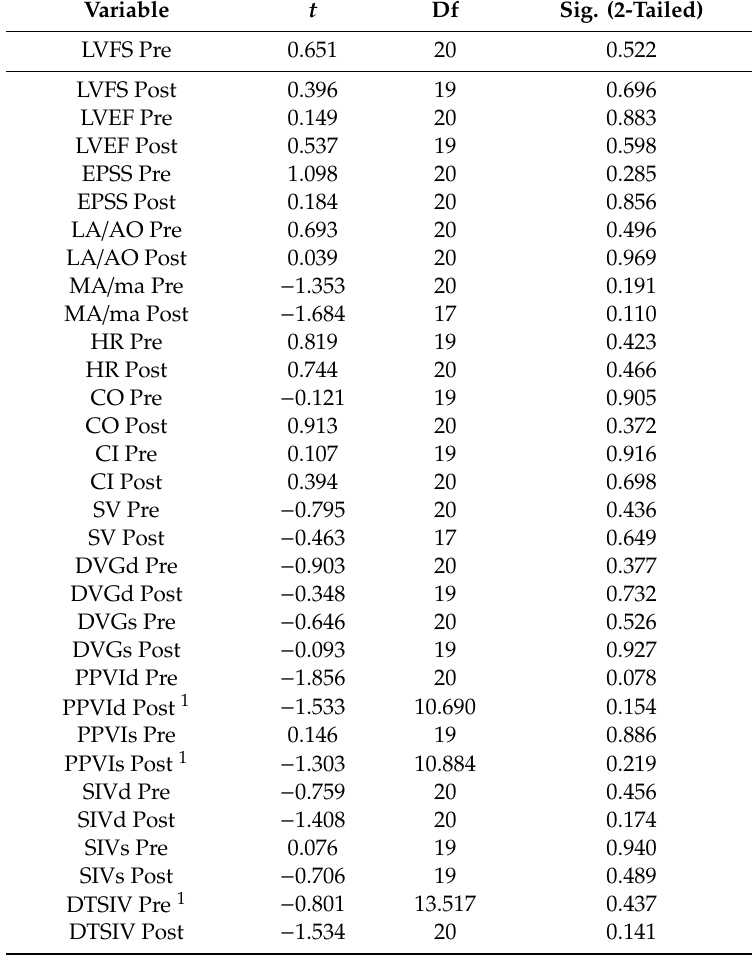
Table 8. Independent t -test for sex di ff erences in the echocardiographic variables.